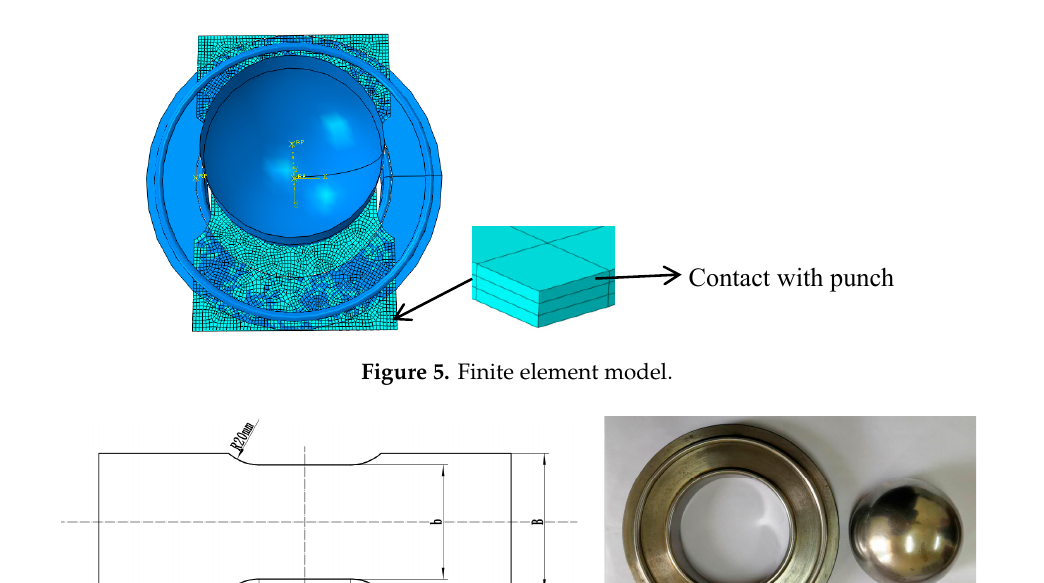
Figure 5. The dimensions of specimens and moulds ( a ) stepped specimen; ( b ) punch and die.